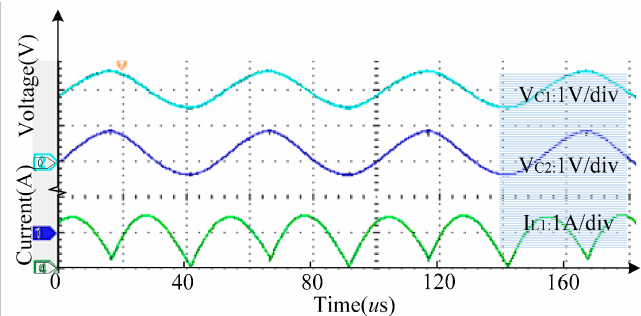
Figure 12. The voltage V C 1,2 and current I L 1 waveform of switched-capacitor C 1 during the balancing progress of ZCS mode.